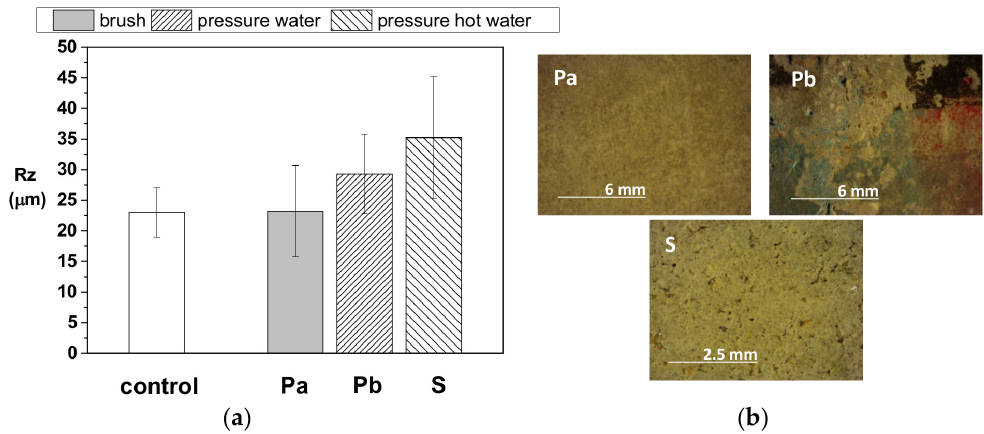
Figure 8. ( a ) Roughness ( R z , μ m) of the anti ‐ graffiti coated samples (P, permanent coating; and S, sacrificial coating) after different cleaning graffiti procedures with (Pa) detergent and brush, (Pb) detergent and pressure water and (S) hot pressure water. Four painting ‐ cleaning cycles on Pa and Pb and one on S coated samples. Control, untreated and unpainted concrete. ( b ) Stereomicroscope images of the anti ‐ graffiti coated surfaces on which R z was measured after removal of graffiti.